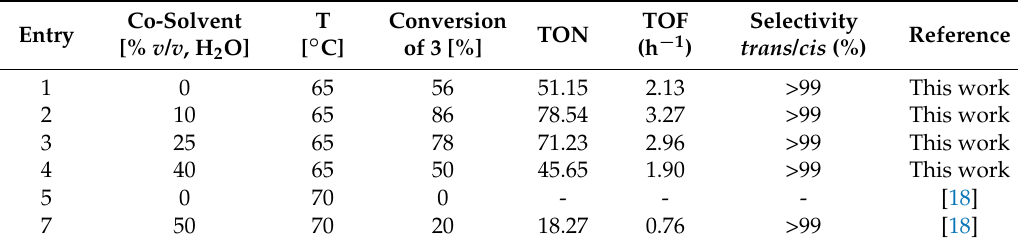
Table 2. Heck coupling of iodobenzene with ethyl acrylate catalyzed by GTL σ